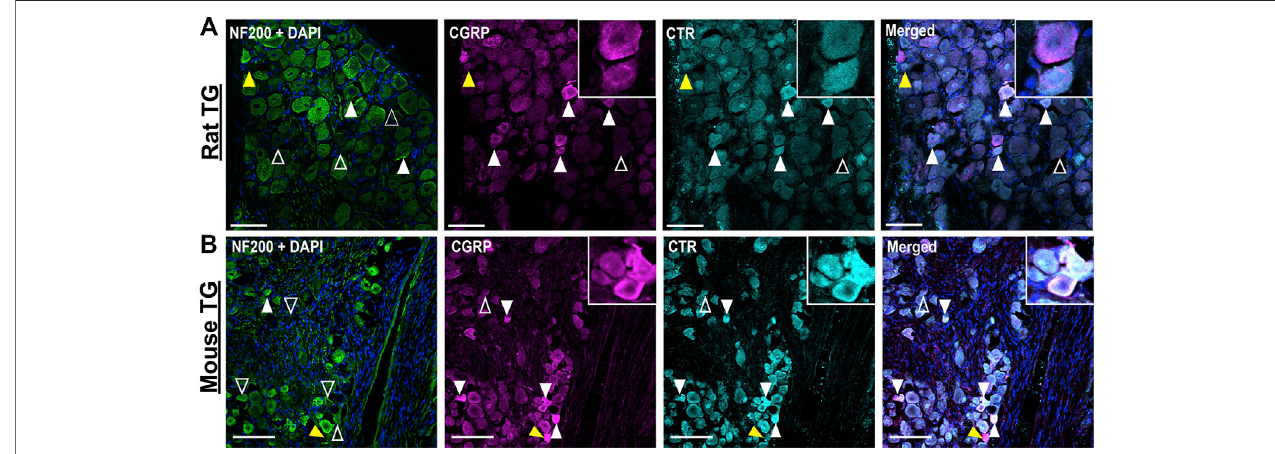
FIGURE 4 | Immunohistochemical localization of CGRP (pAb36001, 10 µg/ml) and CTR (pAb188, 10 or 20 µg/ml) together with NF200 (3 µg/ml) in adult rat and mouse TG. (A) CGRP and CTR in rat and (B) CGRP and CTR in mouse. NF200 is shown for reference. Filled white arrowheads indicate examples of positive staining; empty arrowheads indicate examples of an absence of staining; yellow arrowheads indicate expression in adjacent neurons. Image brightness and contrast were adjusted for presentation purposes and merged in FIJI. Scale bar = 100 μ m. Images and quanti fi cation are representative of six rats and six mice (three male and three female).